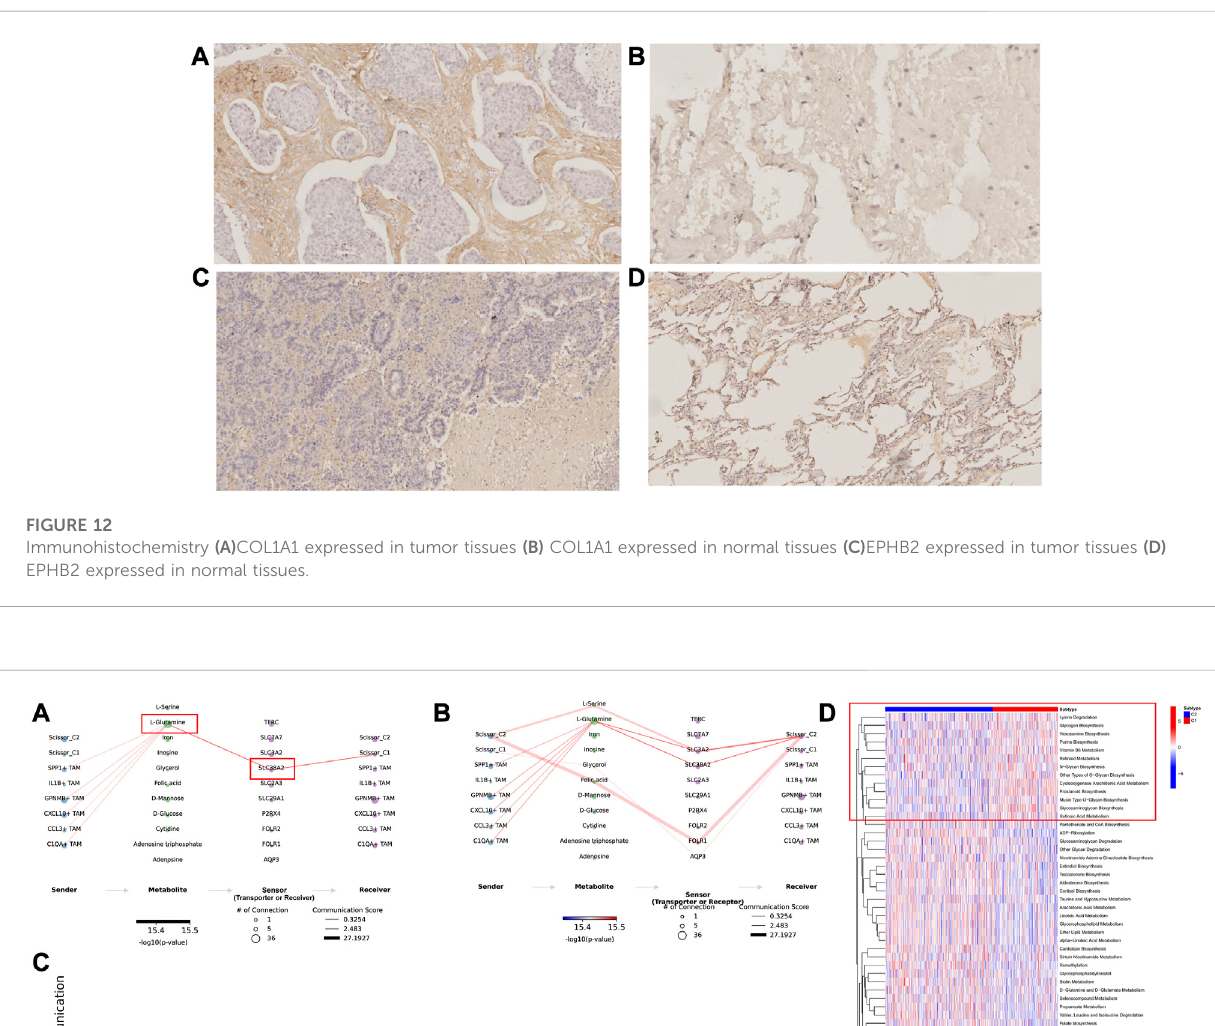
metabolic activity (Figure 13D) and sensitivity to interactions with TAM (Figure 8C). This elevated metabolic activity may explain the positive the communication fl ow, Scissor_C1 uses the SLC38A2 transporter to uptake TAM-secreted glutamine (Figures 13A, B). Glutamine uptake is indispensable for tumor cell growth and metastasis; in